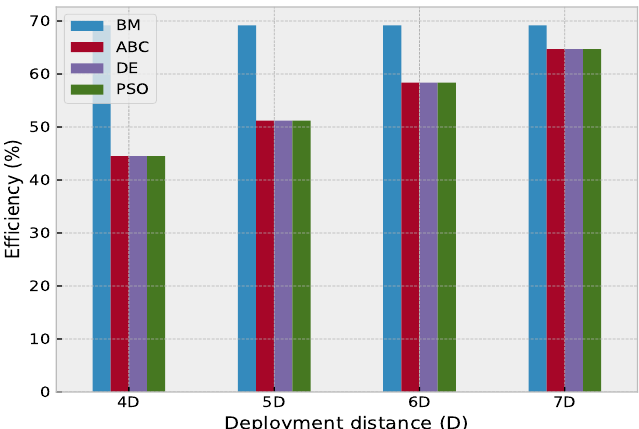
Figure 19. Plant efficiency variation for a 8 m/s